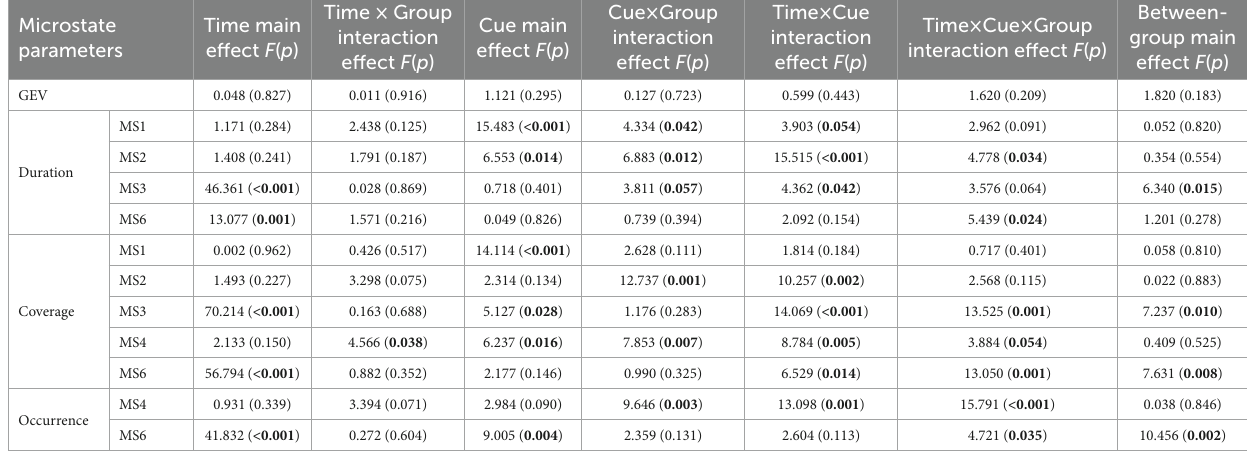
TABLE 4 Changes in microstate parameters before and after treatment in the MDD + NSSI group after receiving different treatment. Microstate